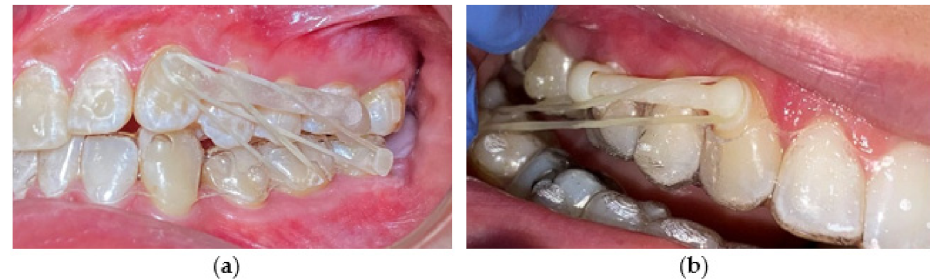
Figure 1. Examples of bonded 3D printed distalizers with an individual base for a tooth-borne hybrid approach in Class II unilateral malocclusions’ treatment and comparison of two biocompatible resins ( a ) transparent resin- Dental LT Clear V2; ( b ) opaque white Denture Teeth